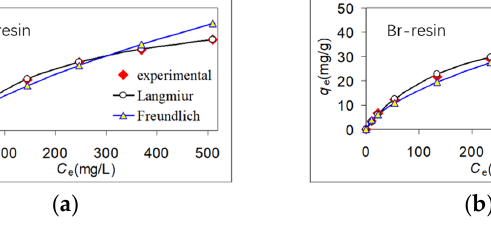
Figure 1. Theoretical and experimental non-linear isotherm plots of Cd 2+ adsorption on halide-loaded Amberlite IRA 900 resins. ( a ) Cl-resin; ( b ) Br-resin; ( c ) I-resin. Table 1. Isotherm parameters obtained from linear analysis of Cd 2+ adsorption on X − -loaded resins. K a q m (mg/g) R 2 Langmuir model Cl-resin